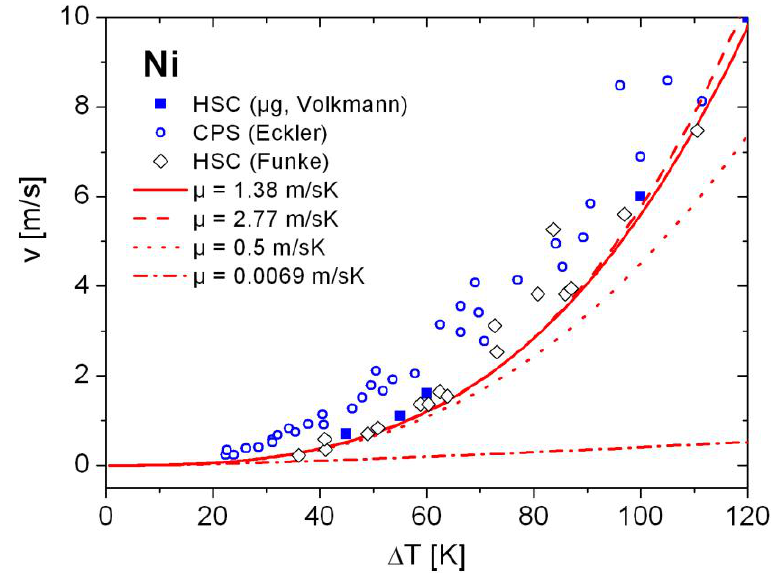
Figure 7. Dendrite growth velocity V as a function of undercooling ∆ T , measured for pure Ni, using a Capacity Proximity Sensor, CPS (open circles) [49], a High Speed Camera (HSC) in terrestrial experiments (open diamonds) [11] and a High Speed Camera in reduced gravity experiments using the TEMPUS facility during parabolic flight campaigns (full squares) [50]. The lines give the predictions of dendrite growth theory assuming collision-limited growth (dashed), thermally limited growth (dotted) and diffusion limited growth (dash-dotted). The solid line gives a fit through the results obtained from microgravity experiments in which forced convection is